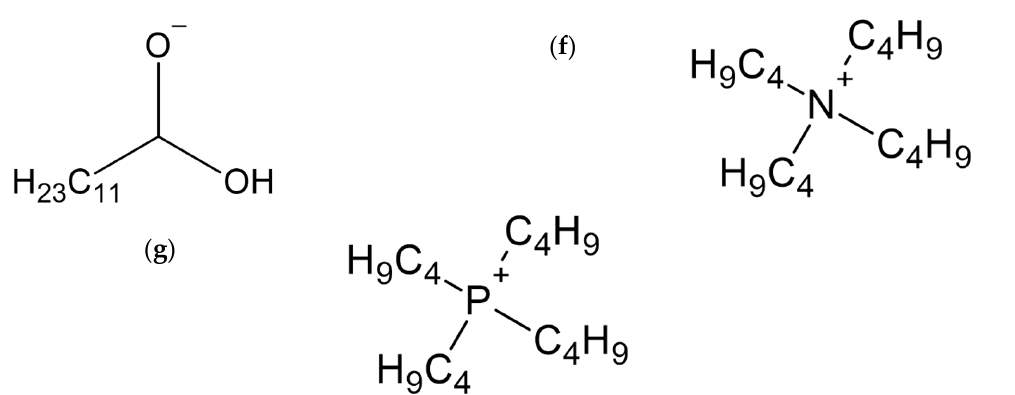
Figure 2. Molecular structure of the anions and cation used: ( a ) [EHPMEH], ( b ) [DEHP], ( c ) [BEHP], ( d ) [DICP], ( e ) [C11O], ( f ) [N 4444 ] and ( g ) [P 4444 ].